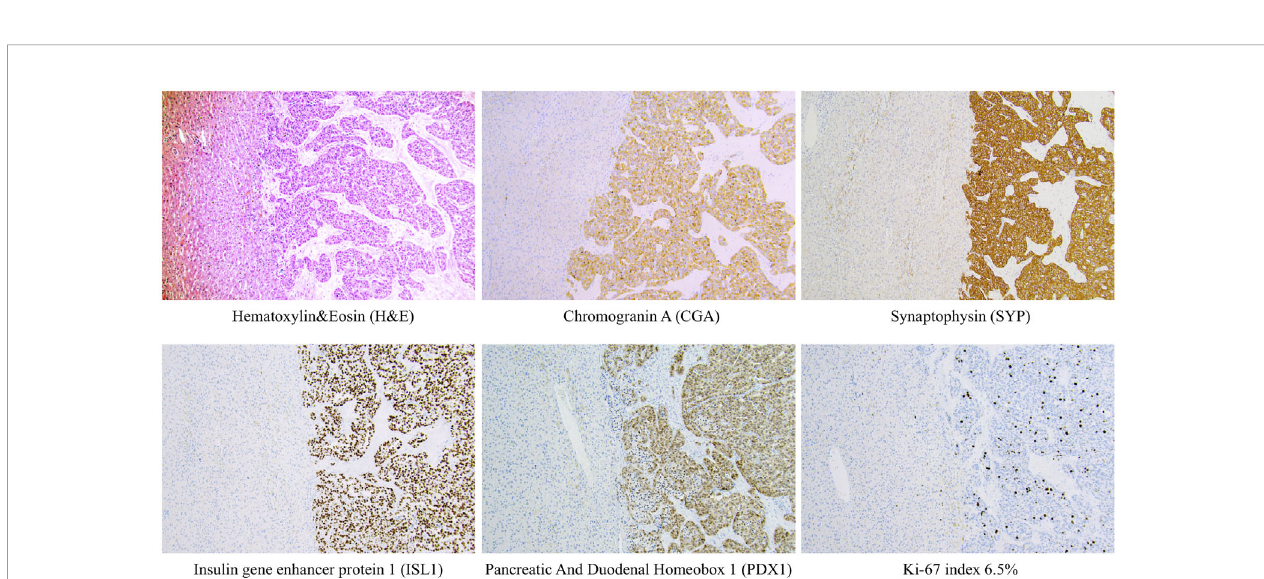
FIGURE 2 | Examples of routine histological and immunohistochemical features of a metastatic pan-NETs WHO grade 2 (Pan-NET G2) from the Karolinska cohort. Metastatic Pan-NETs tissue is evident to the right, while the left section of each image depicts liver tissue. Note the well-differentiated tumoral growth pattern on routine H&E staining. Tumor cells were diffusely positive for markers of neuroendocrine differentiation (CGA, SYP, ISL1) and displayed stainings indicating a pancreatic origin (ISL1, PDX1). The tumor grade was determined to G2, which in this manuscript would translate to the hypothetical G2a category. This patient had been previously diagnosed with a primary pan-NET (data not shown). All photomicrographs were magni fi ed